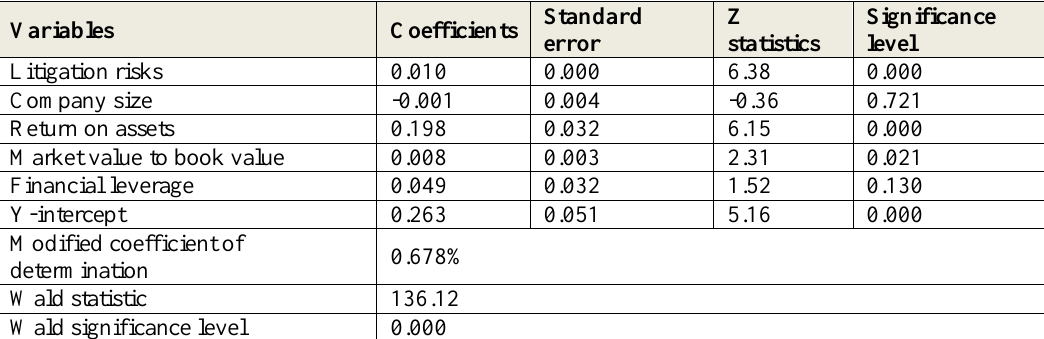
Table 14. Final estimation of the first hypothesis